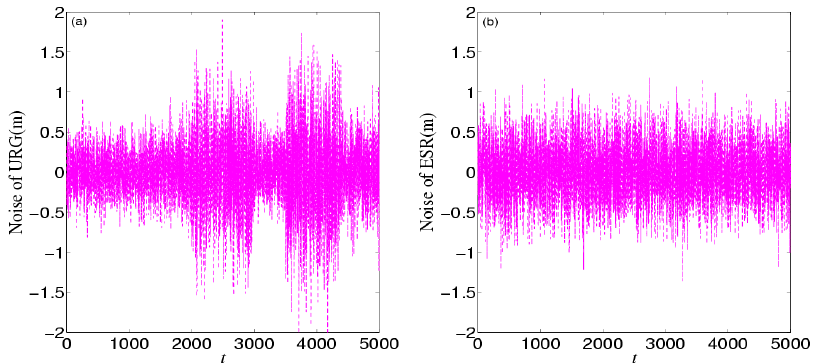
Figure 12. The noise of ( a ) URG and ( b ) ESR in the second experiment.